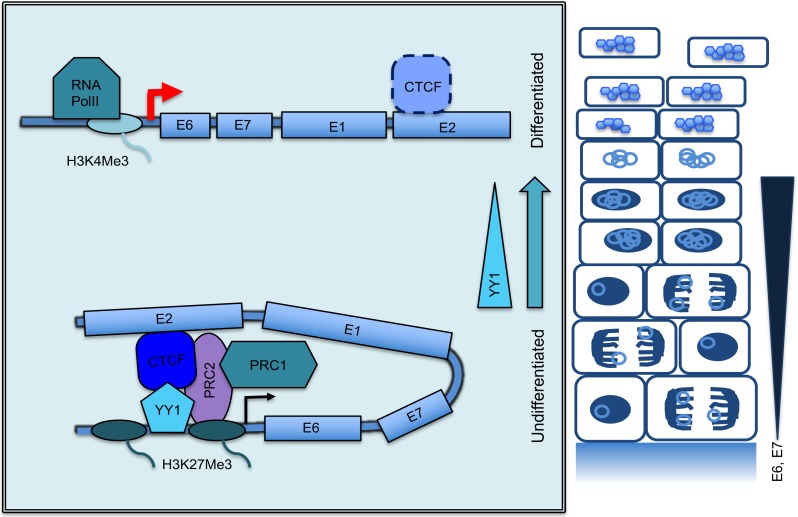
Model of differentiation-dependent looping and epigenetic control of HPV oncogene transcription.The HPV life cycle is dependent on infection of differentiating epithelia. Infection is established in the undifferentiated basal cells, in which a tightly controlled programme of viral gene expression is initiated. Expression of viral early genes (E6, E7) is attenuated in undifferentiated cells by the establishment of a CTCF-YY1–dependent chromatin loop of epigenetically repressed chromatin. As cells begin the programme of terminal differentiation, increased E6/E7 expression is required to maintain the cell in a proliferative state. This is coordinated by a differentiation-induced reduction in YY1 protein expression, which releases the repressive chromatin loop and attenuates PRC complex recruitment and loss of H3K27Me3 deposition. Increased accessibility and reduced H3K27Me3 at the viral enhancer results in de-repression of the early promoter, increased RNA Pol II recruitment, and H3K4Me3 deposition, resulting in increased E6/E7 oncogene expression. CTCF, CCCTC-binding factor; H3K4Me3, histone 3 lysine 4 trimethylation; H3K27Me3, histone 3 lysine 27 trimethylation; HPV, human papillomavirus; PRC, polycomb repressor complex; RNA Pol II, RNA polymerase II; YY1, Yin Yang 1.